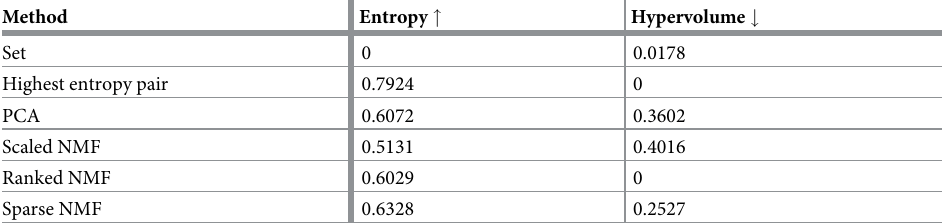
Table 2. Evaluation of performance. The ideal solution has a high relative entropy but minimal hypervolume, which is indicated by the arrows (( " ) represents that higher value is generally better, ( # ) denotes that lower is preferable). The aim of dimensionality reduction is to compress the high number of objectives and retain as much information for ranking as possible. This results in a similar solution to the highest entropy pair, but takes all other objectives into